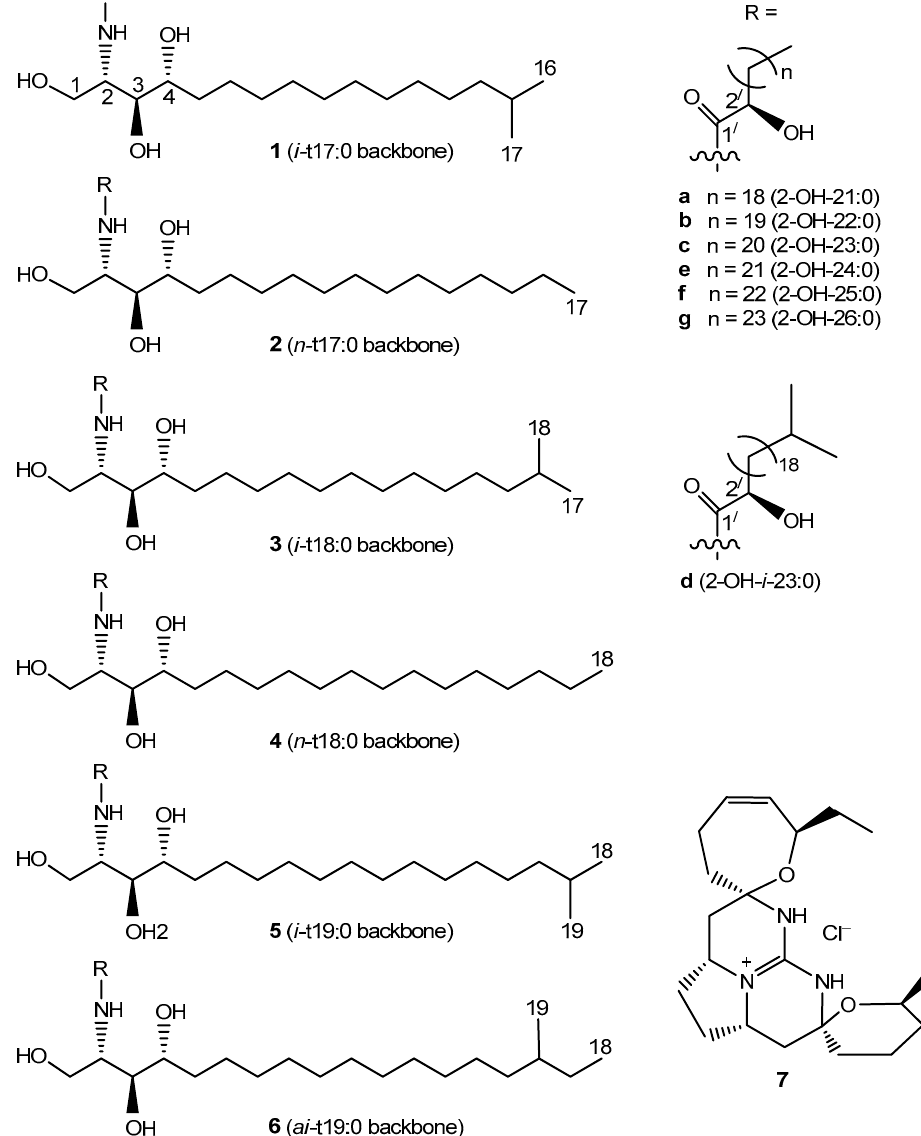
Figure 1. Phytoceramides ( 1b , 2b , 2e , 2f , 3a – g , 4a – c , 4e, 4f , 5b – g , 6b – g ) and crambescidin 359 ( 7 ) from the sponge Monanchora clathrata . Shorthand designation [8] was used: for example, iso -methyl- branched and normal -chain trihydroxy C 17 sphingoid bases were denoted as i -t17:0 and n -t17:0, respectively; anteiso -methyl-branched trihydroxy C 19 sphingoid base was denoted as ai